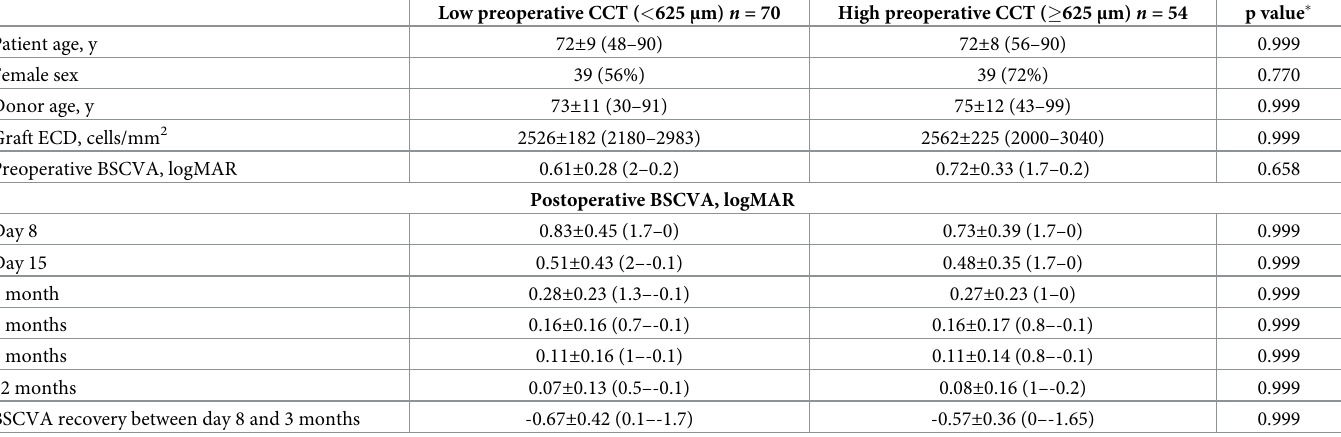
Table 4. Comparison of eyes with low preoperative CCT ( < 625 μ m) and high preoperative CCT ( � 625 μ m) in terms of pre/perioperative variables, postoperative BSCVA, and BSCVA recovery.